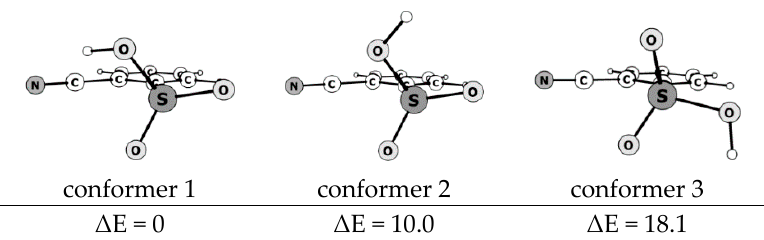
Figure 4. The structure of the 2-CN-BSA conformers and their relative energies ( Δ E, kJ mol − 1 ).